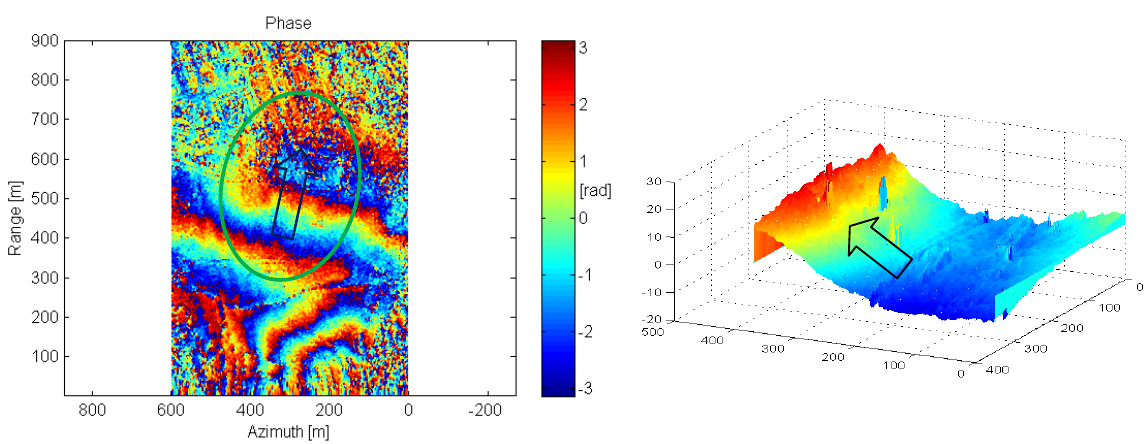
Figure 11. ( a ) Phase map (in rad) from an interferometric measurement in single-pass mode over the same scenario. ( b ) Extracted Digital Elevation Model (DEM) of part of the scenario after phase unwraping and geocoding (Peaks correspond to PARCs and power line towers). The ellipse shows the zone of interest and the arrow the orientation of the slope where the DEM is